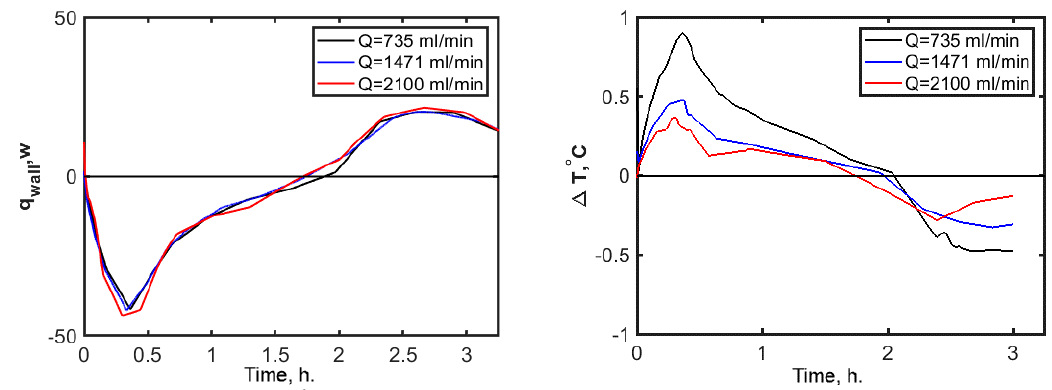
Figure 15. Effect of flow rate on wall heat transfer and temperature difference. Figure 15. E ff ect of flow rate on wall heat transfer and temperature di ff erence.